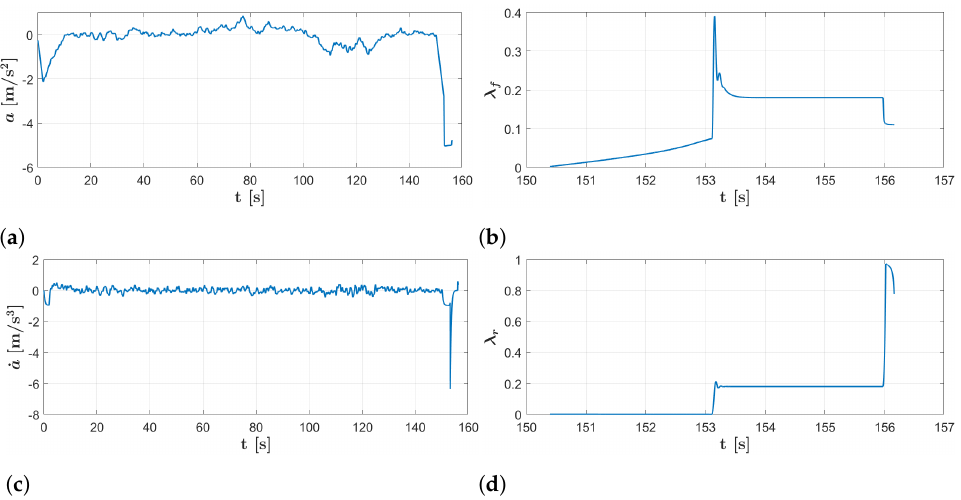
Figure 8. Road-Grip aware Driving Functionalities: vehicle-following and hard emergency braking. Time-history of the ego-vehicle acceleration ( a ), jerk ( c ), front tire ( b ) and rear tire ( d ) longitudinal slip